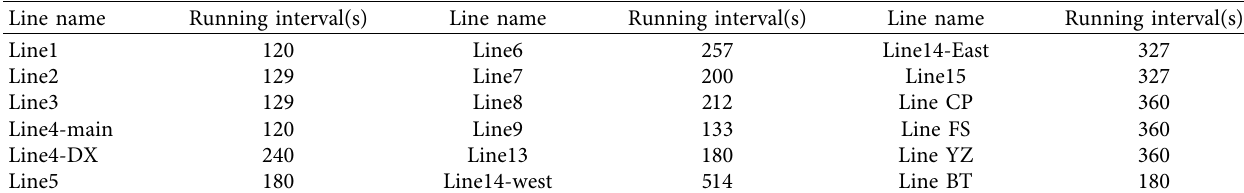
Table 4: Train running interval of lines in the morning peak.